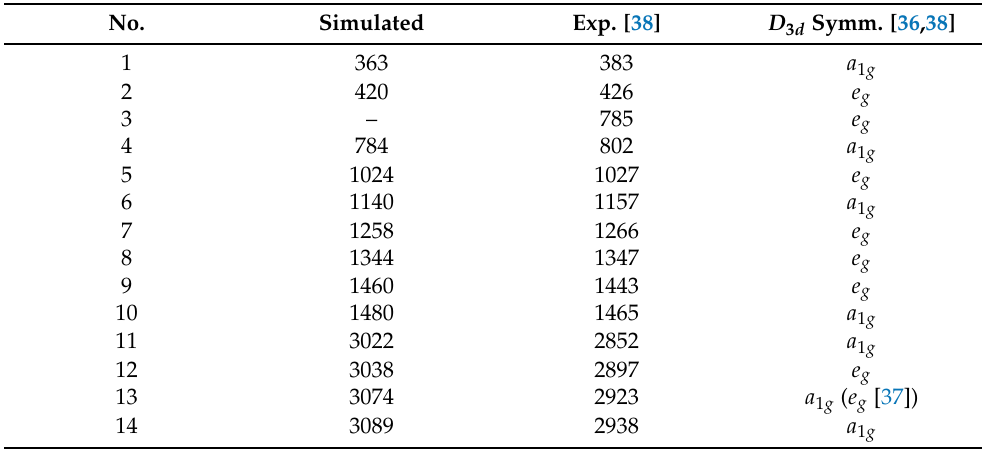
Table 1. Simulated Raman-active frequencies (in cm − 1 ) of a cyclohexane molecule. In addition, experimental results from Ref. [38] are shown for comparison.